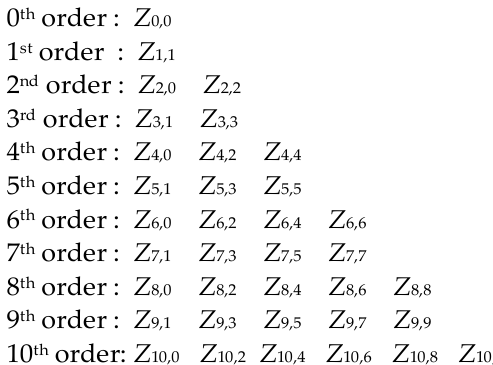
Figure 7. The ten order Zernike moments.